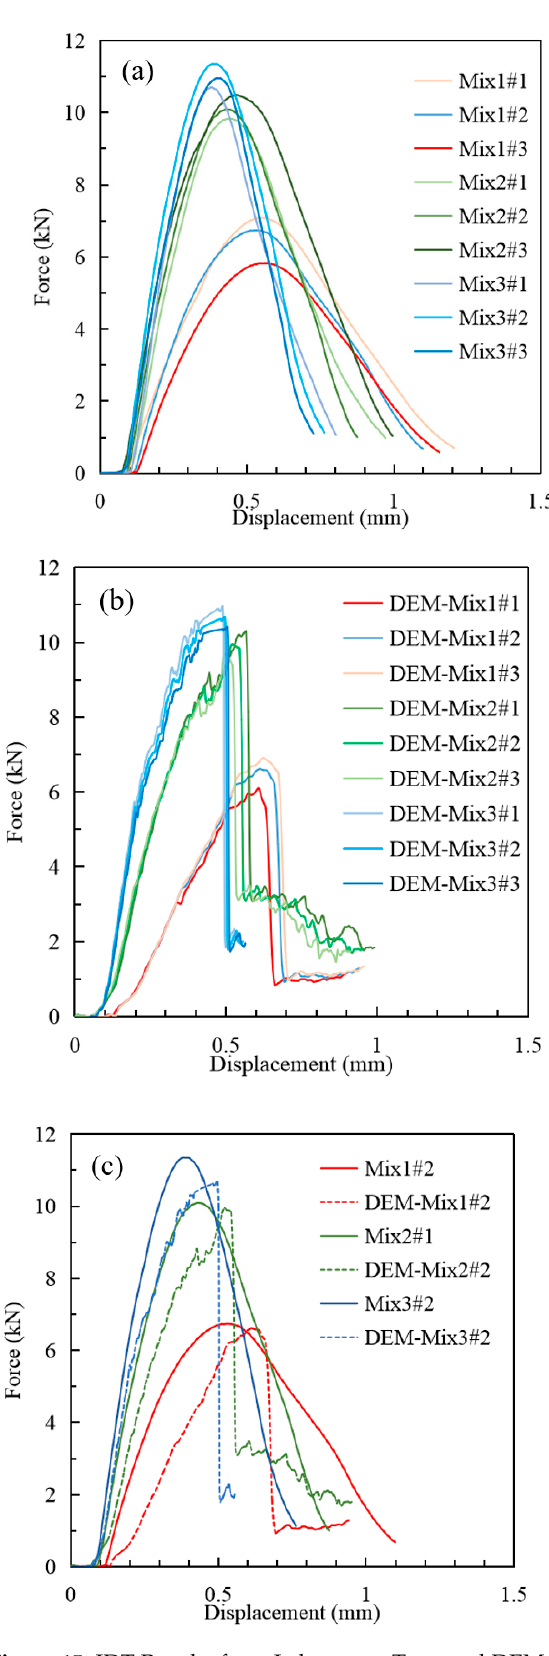
Figure 15. IDT Results from Laboratory Tests and DEM simulation. ( a ) Laboratory Tests. ( b ) DEM Simulation. ( c ) Comparison between Laboratory Tests and DEM Simulation.